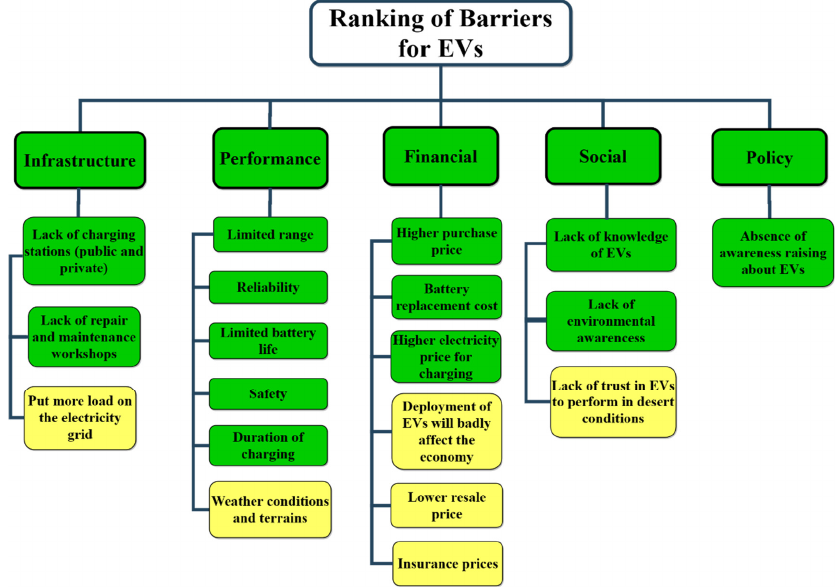
Figure 8. Thematic framework.